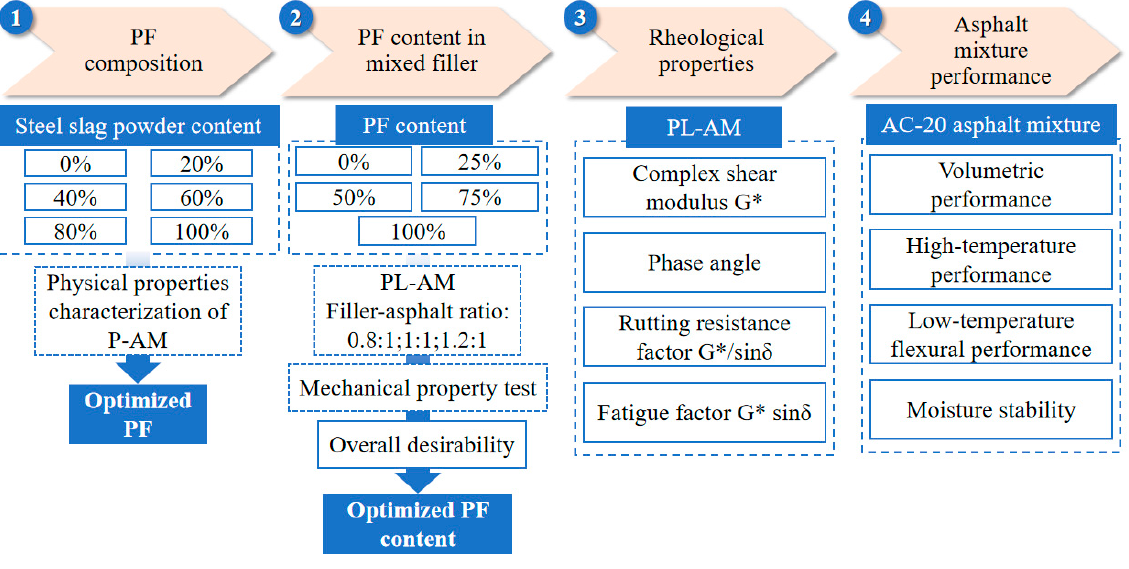
Figure 2. Outline of